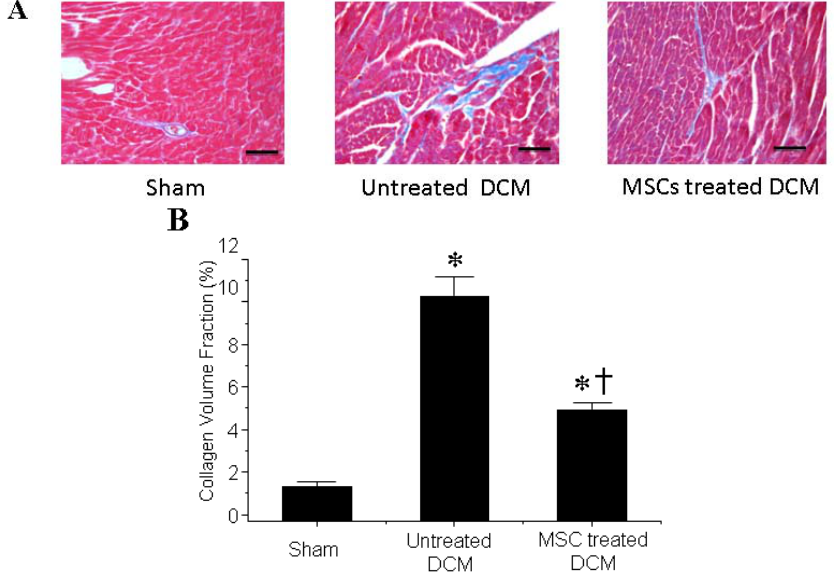
Figure 2. Mesenchymal stem cells (MSCs) transplantation reduces myocardial fibrosis of dilated cardiomyopathy (DCM); ( A ) Representative myocardial sections stained with Masson’s trichrome. Scale bars = 40 μ m; ( B ) MSCs transplantation decreases collagen volume fraction of DCM. * p < 0.01 vs. sham group; † p < 0.01 vs . untreated DCM group.